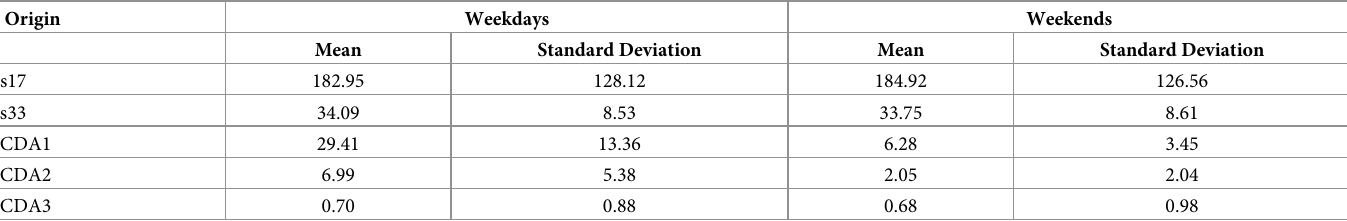
Table 1. Characteristics of the background time